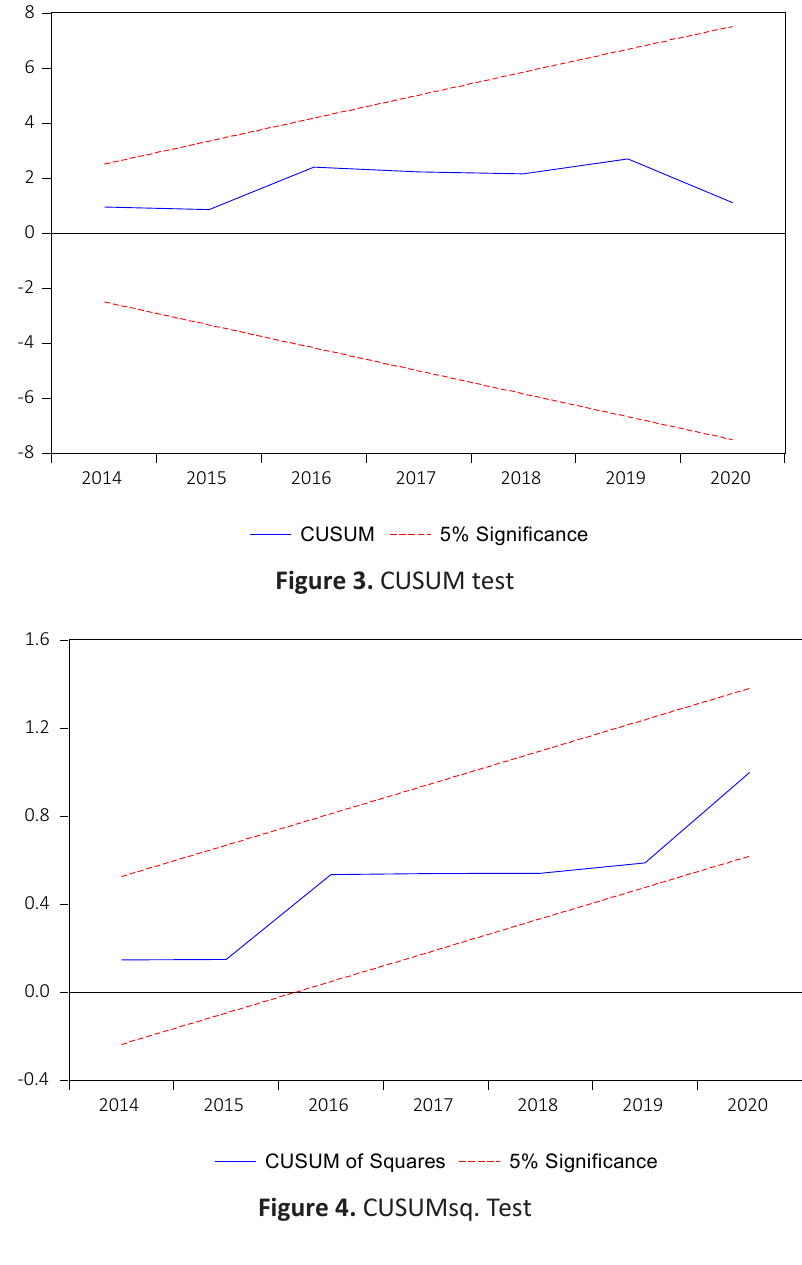
Figure 4. CUSUMsq.